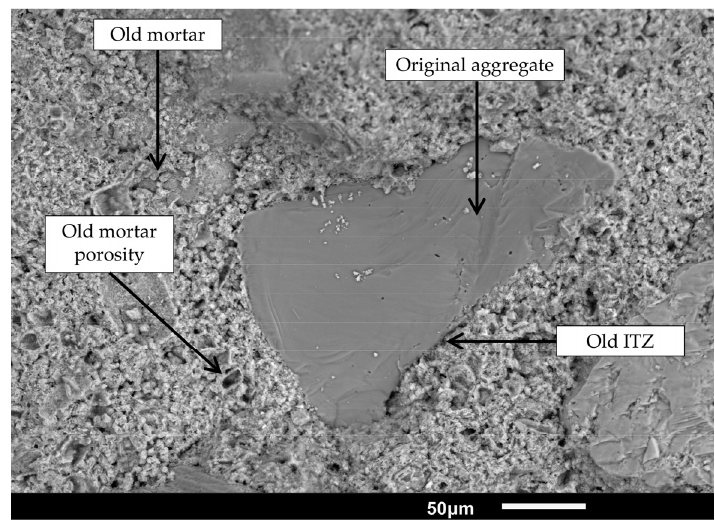
Figure 1. SEM photomicrograph of RFA* to 50 µm.